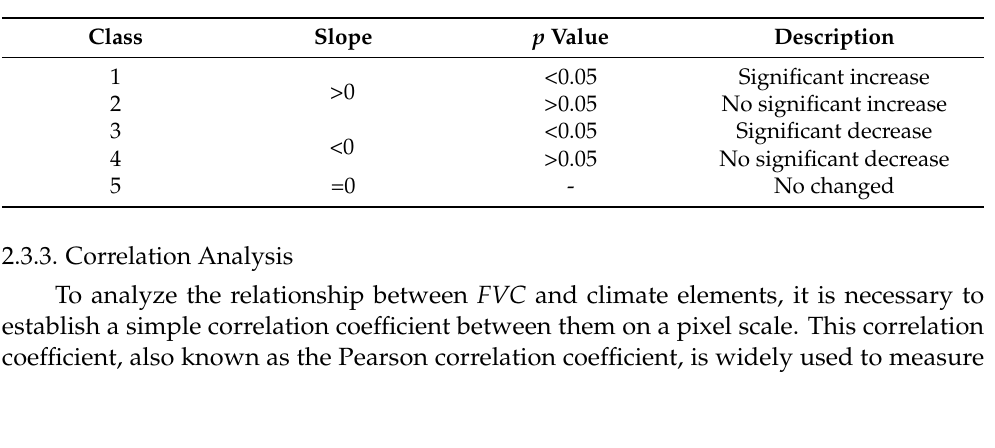
Table 2. Classification of change trend